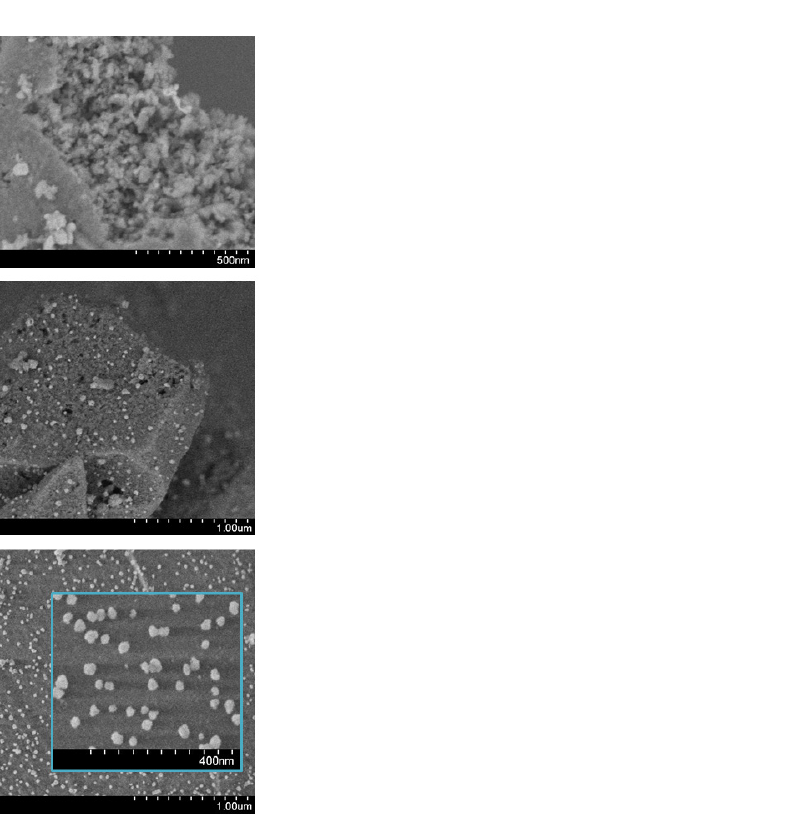
Figure 2. Scanning Electron microscopy images of ( a ) NiBaAlO, ( b ) NiCaAlO, and ( c ) NiMgAlO